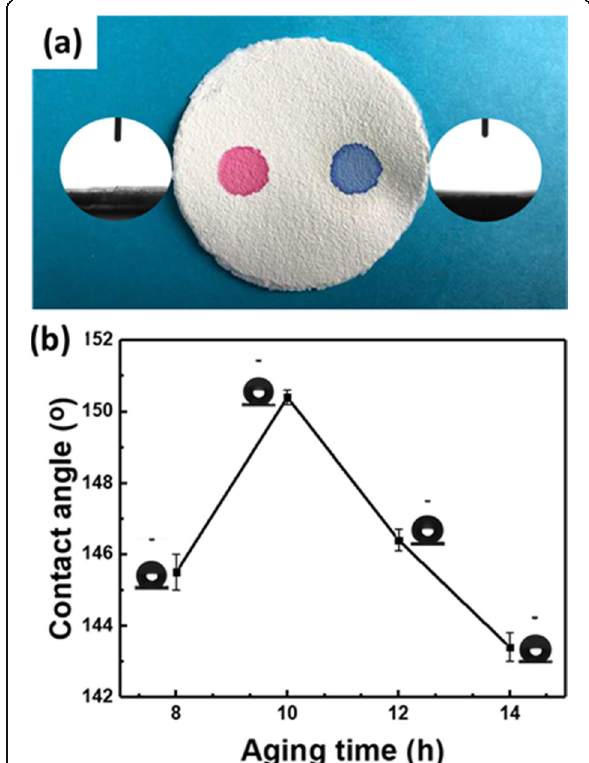
Fig. 5 a Optical photo of the F-60 membrane dropped with carbon tetrachloride (left side, stained by methyl red) and water (right side, stained by methylene blue). b Effect of aging time of MTMS on the contact angle of the modified F-60